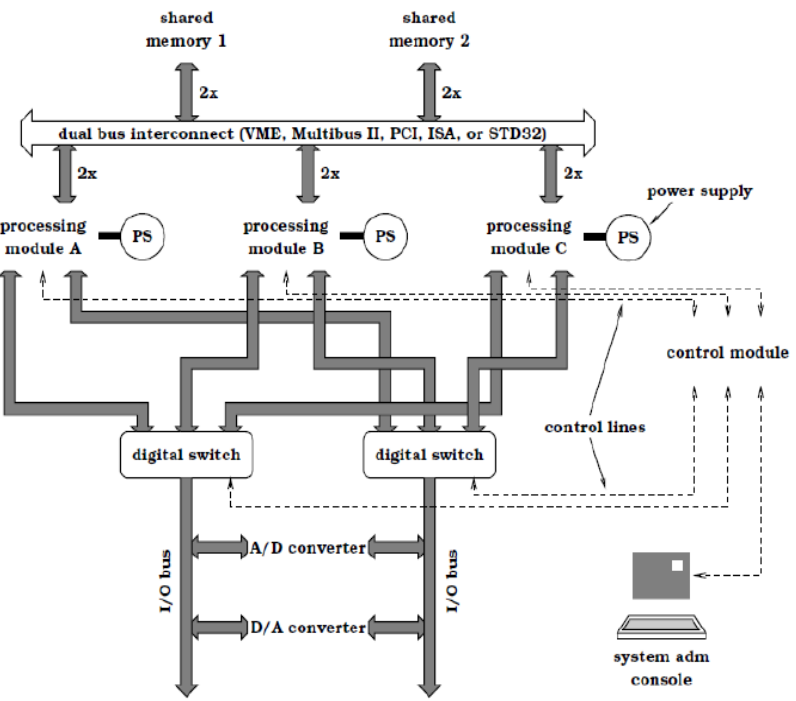
Fig. 1. The architecture of real-time computing system presented by Fricks et al. (Fricks and Trivedi,